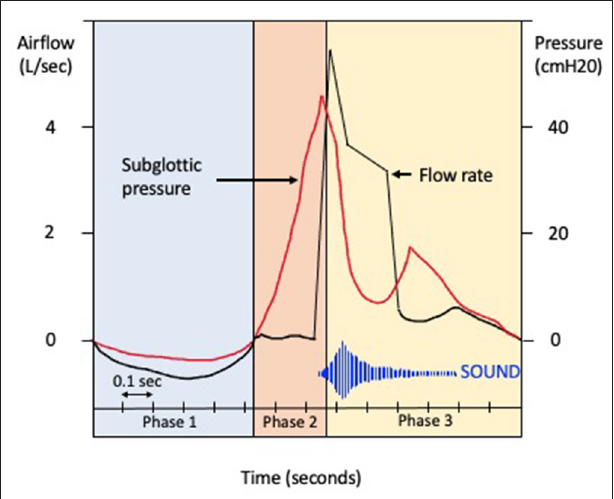
FIGURE 1 | Phases of cough. Schematic representation of the changes in airflow (liters per second) and subglottic pressure (centimeter of water) during the phases of cough. Phase 1. The glottis opens on activation of the cough reflex, and a deep breath is inhaled (inspiratory phase). Phase 2. The glottis then closes and expiratory muscles forcibly contract (compressive phase), with a transient increase in intrathoracic pressure. Phase 3. The glottis opens with rapid airflow, causing oscillation of the bronchial tissues (expulsive